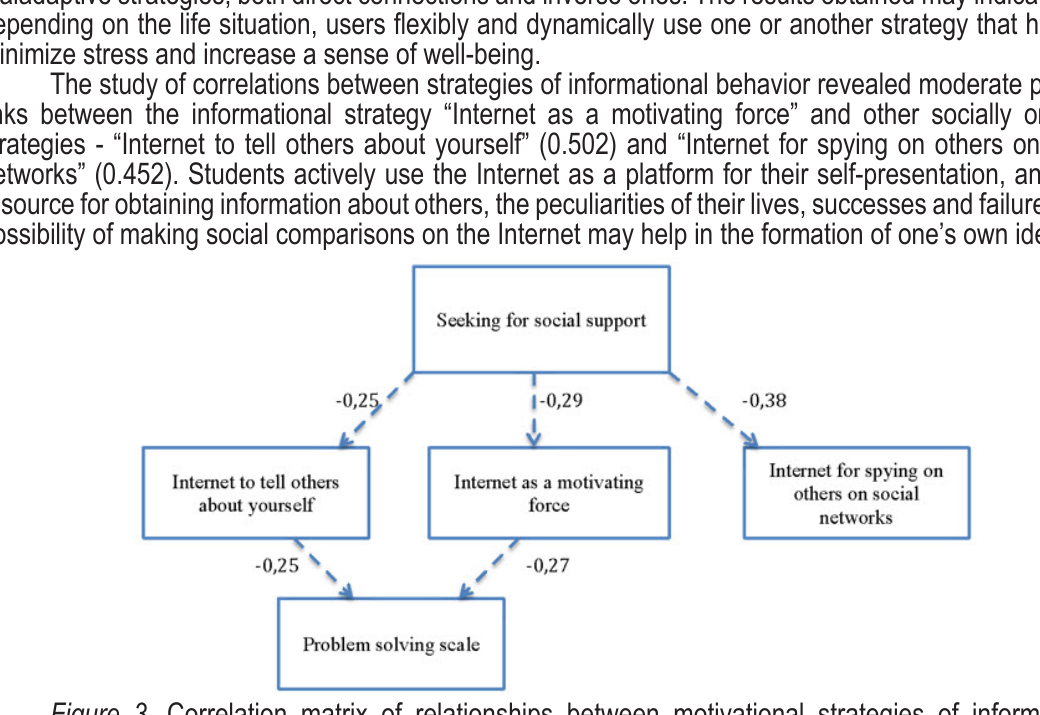
Figure 3. Correlation matrix of relationships between motivational strategies of informational behavior and strategies of coping